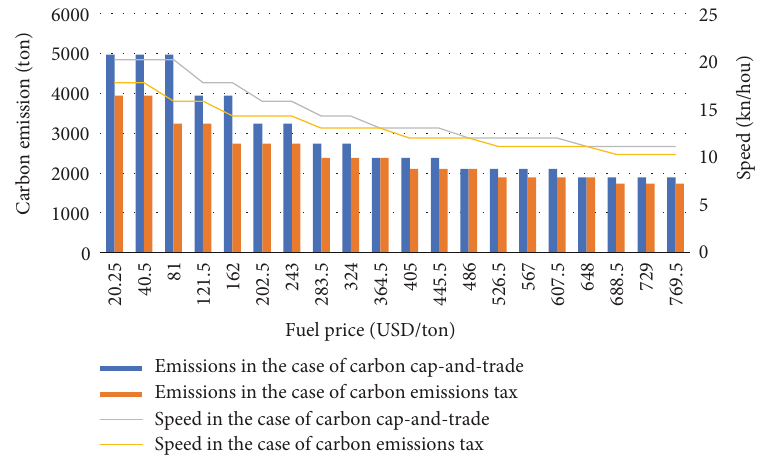
Figure 6: Computation results for oil price